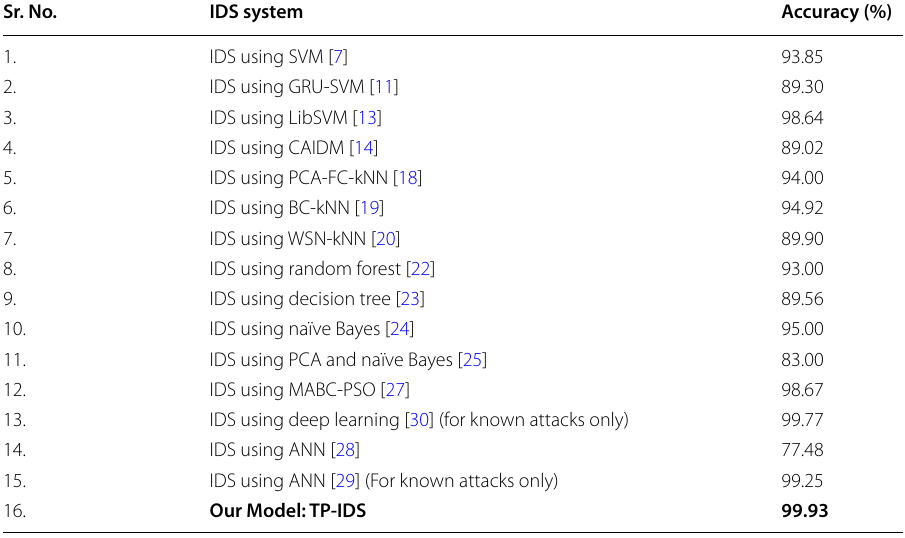
Table 1 Accuracy comparison of existing IDS systems and Our Model (TP-IDS) Sr.